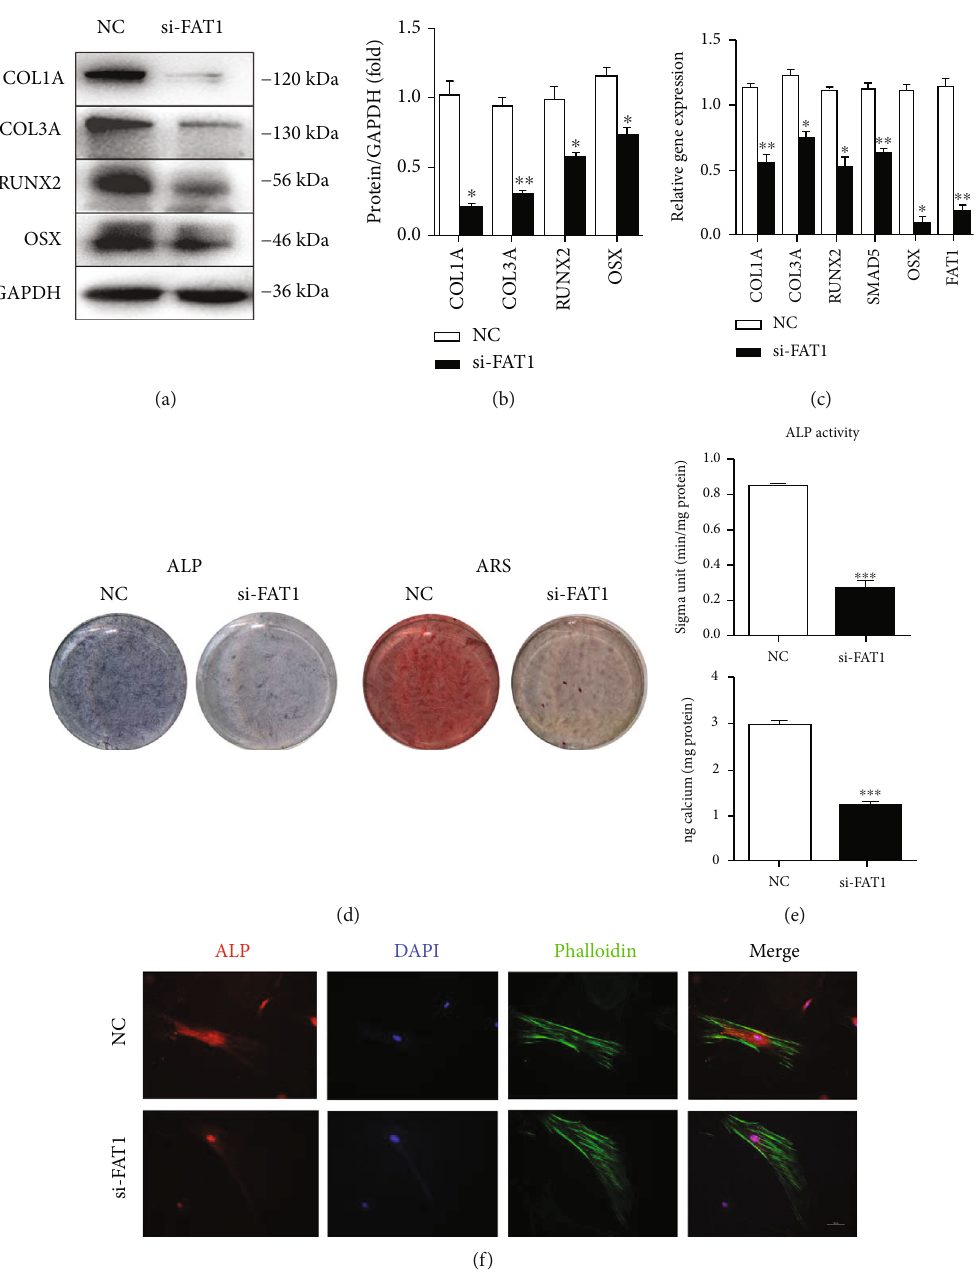
Figure 3: circFAT1 silencing inhibits osteoblastic di ff erentiation potential of PDLSCs. (a) – (c) Western blot and RT-qPCR showed that osteogenic markers (RUNX2, OSX, COL1A, and COL3A) were downregulated in the circFAT1 siRNA-treated PDLSCs (si-FAT1 group). (d, e) Silence of circFAT1 reduced the ALP activity of PDLSCs 7 days after osteogenic induction. ARS showed the mineralization of PDLSCs was decreased signi fi cantly in the si-FAT1 group after osteogenic induction for 14 days. (f) Immuno fl uorescence experiments con fi rmed the decreased expression of ALP in the si-FAT1 group. ∗ P < 0 : 05 , ∗∗ P < 0 : 01 , and ∗∗∗ P < 0 : 001